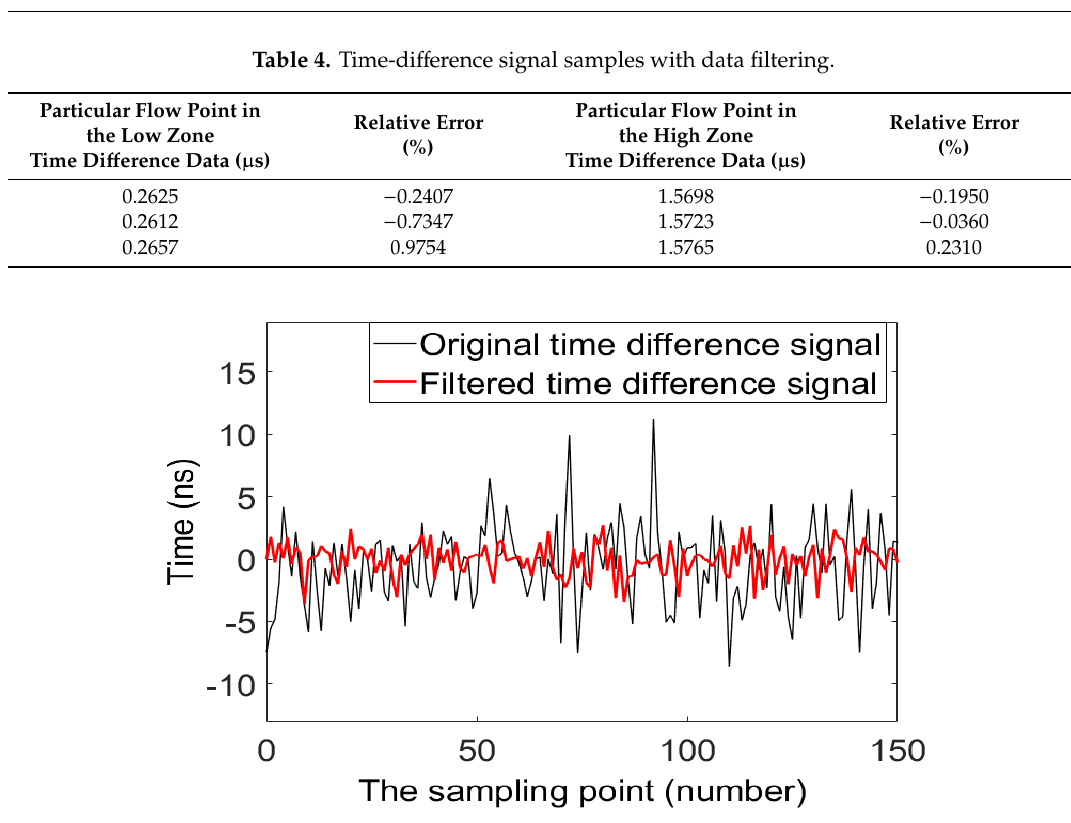
Figure 11. Comparison of time-difference signals before and after data filtering.